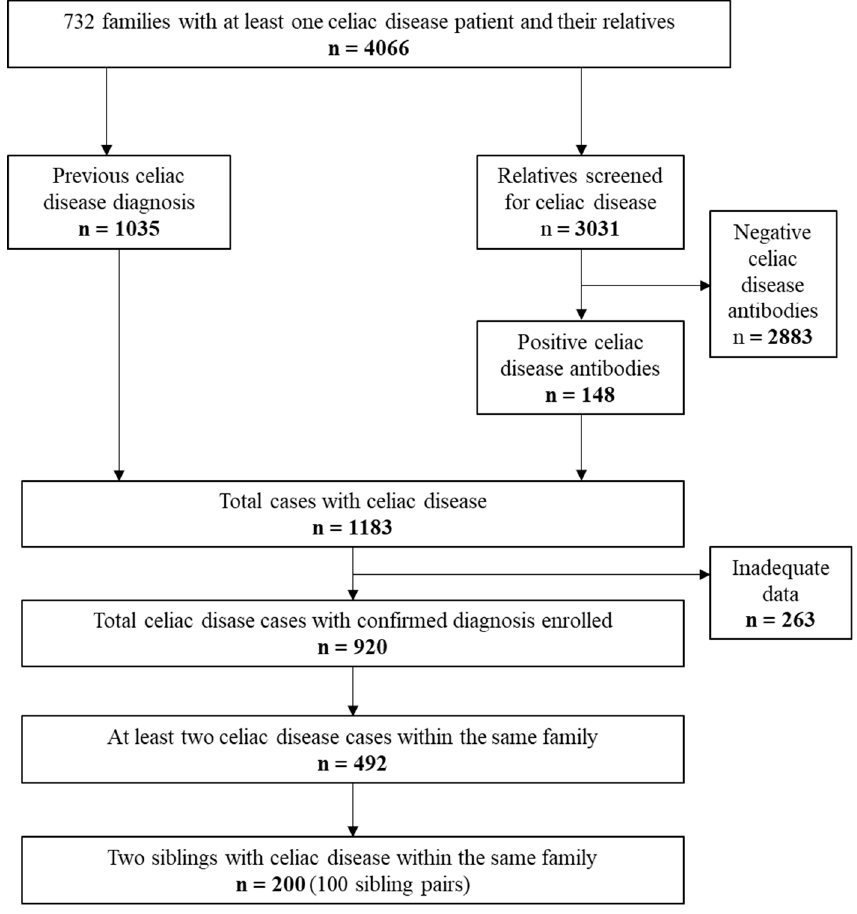
Figure 1. Flowchart of the study.